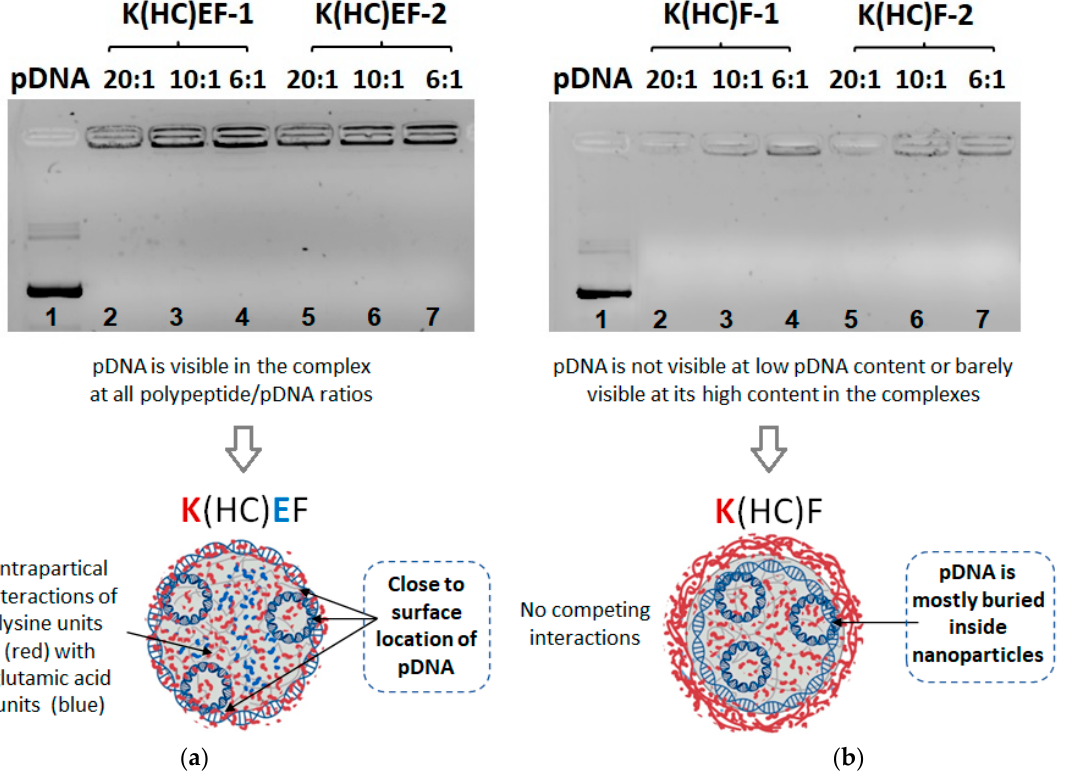
Figure 6. Efficiency and features of pDNA loading into K(HC)EF ( a ) and K(HC)F ( b ) polypeptide nanoparticles followed by S-S cross-linking.